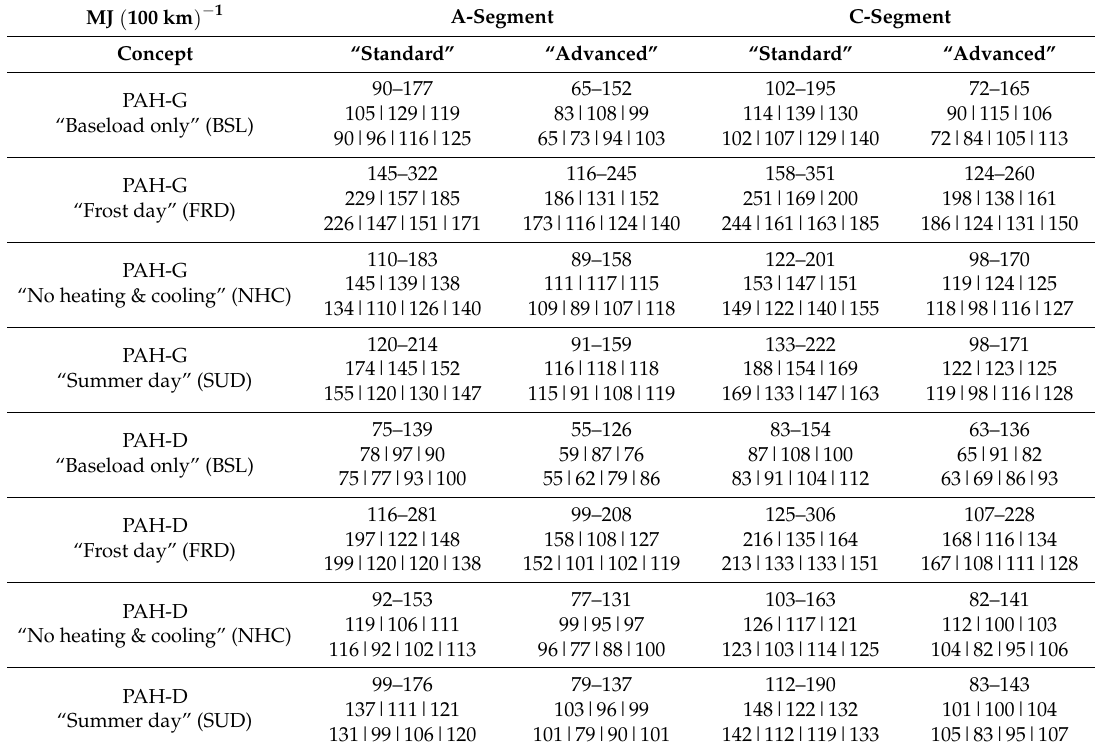
Table A5. Fuel economy figures of PAH considering different load cases and drive cycles. First line: Range of results for all 25 drive cycles. Second line: Values for ECE|EUDC|MVEG; Third line: Values for WLTC-Low|WLTC-Middle|WLTC-High|WLTC-Very high Values for parallel hybrids based on spark ignition (PAH-G) and diesel engines